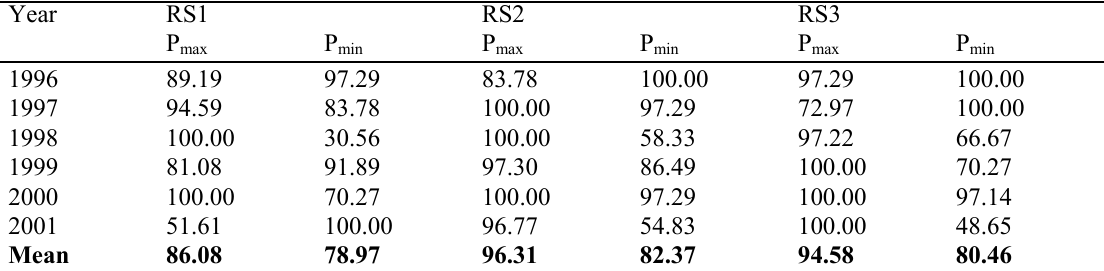
Table 3 General results (%) of forecasting success into the period 1996 to 2001 for RS1, RS2 and